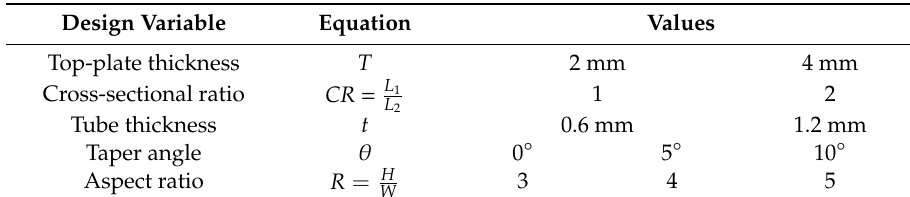
Table 1. Panel geometrical parameters.